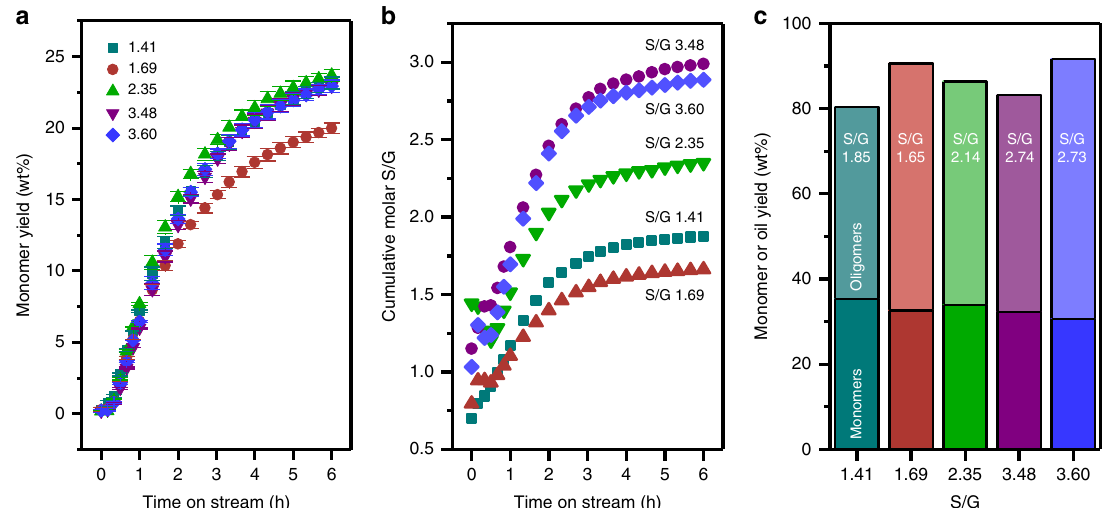
Fig. 2 Yields and S/G ratios from fl ow-through and batch RCF reactions for poplar natural variants. a Cumulative monomer yields for all fi ve poplar natural variants (relative to Klason + acid-soluble lignin in the biomass sample). Error bars are 99% con fi dence intervals for each point generated from a replicate of the experiment on S/G = 1.69 (see Supplementary Fig. 3). b The cumulative S/G ratio calculated from the molar ratio of monomers observed from the RCF reaction. The S/G ratios calculated from monomers recovered are shown in text on the bars. Reaction conditions: 0.96 – 1.15 g of poplar wood (0.26 g lignin), 0.3 g of 15% Ni/C (50/50 SiO 2 ), 190 °C both beds, 0.5 mL min − 1 MeOH, 50 mL min − 1 H 2 at 60 bar. c Final yield of both monomers and oligomers obtained from a batch reaction. Batch Conditions: 0.96 – 1.15 g of poplar wood, 0.15 g 15% Ni/C, 50 mL MeOH, 250°C, 700 RPM, and 30 bar of H 2 (STP)